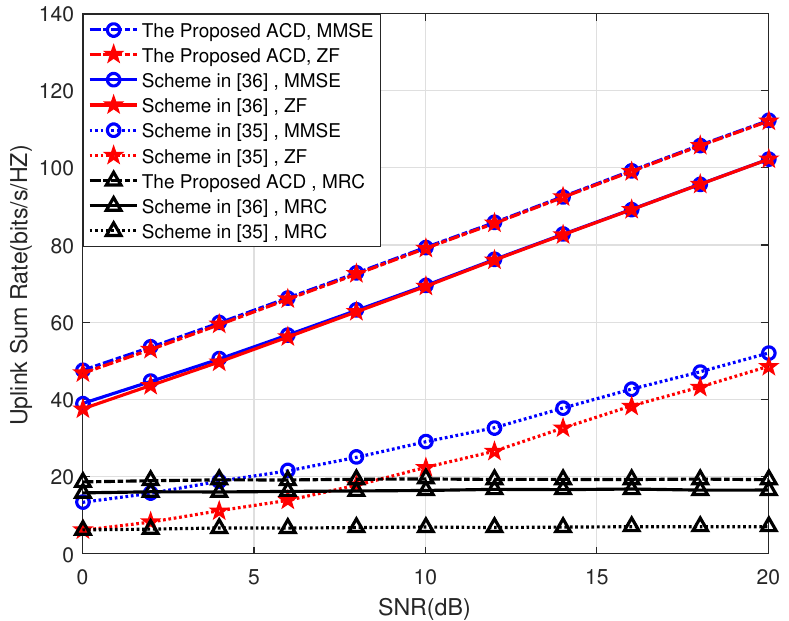
Figure 5. Sum rate comparison between different schemes with zero forcing (ZF), minimum mean square error (MMSE) and maximum ratio combining (MRC) where M (cid:48) = 16.